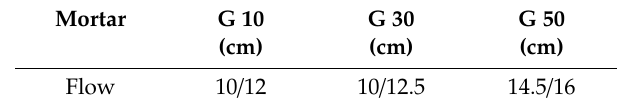
Table 5. Consistency of fresh mortar measured by the Haegermann flow table (free flow / after 15 strokes).